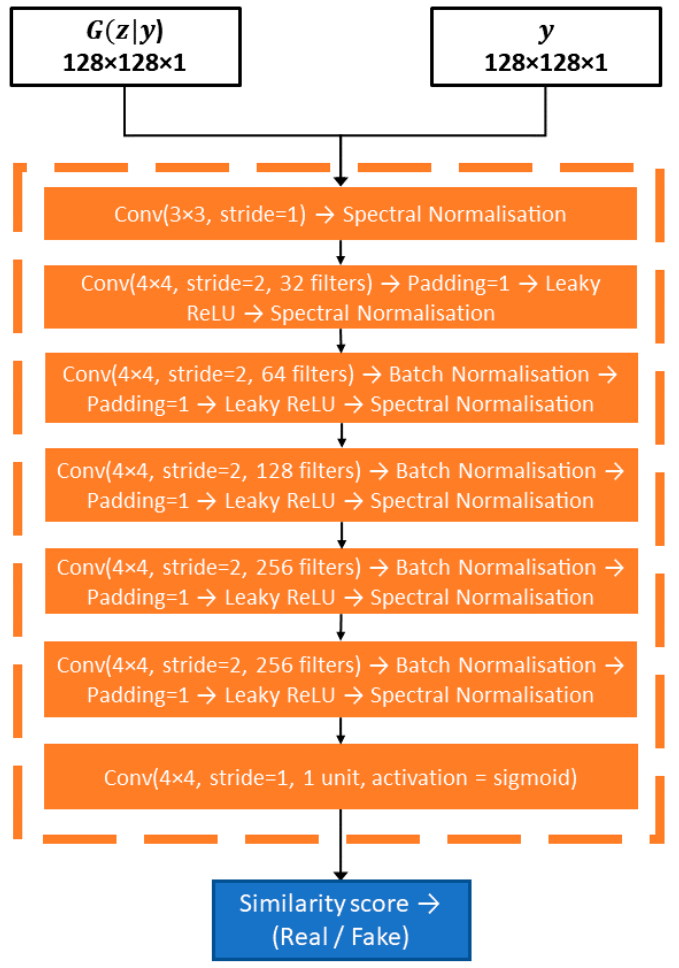
Figure 4. The discriminator architecture proposed for the deep inpainting task.